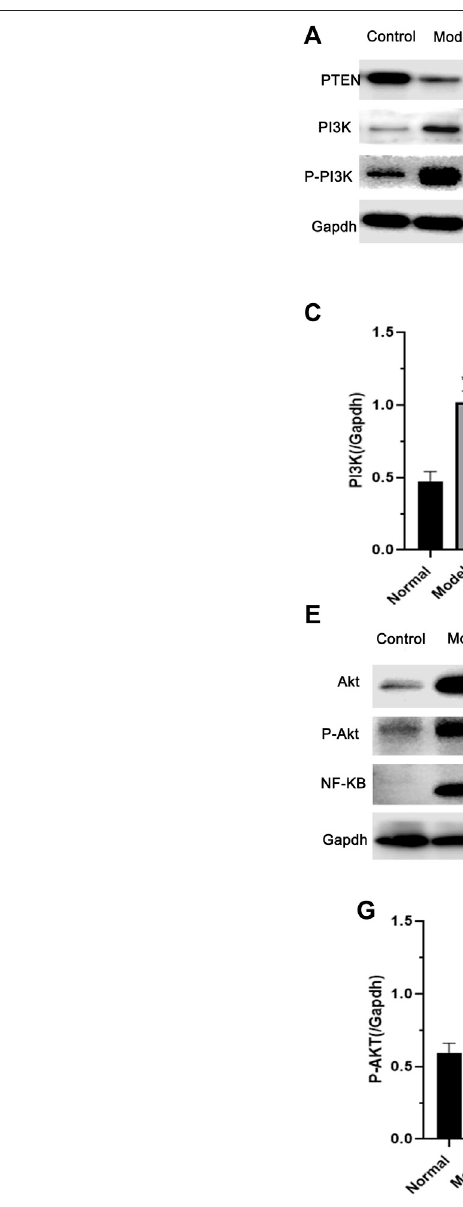
Frontiers in Pharmacology |